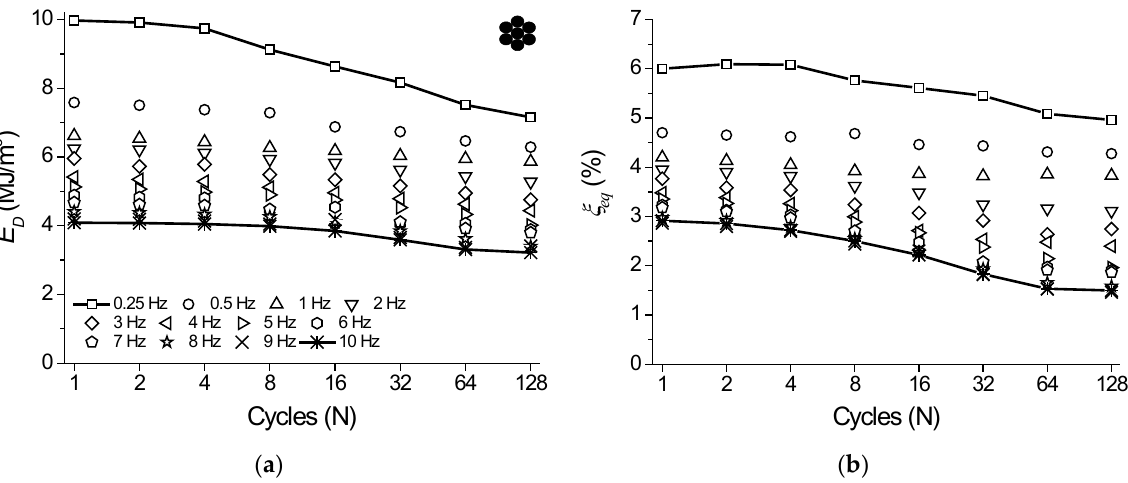
Figure 12. Functional properties variation with cycling as a function of the loading frequencies for the NiTi SMA micro cable. ( a ) Dissipated energy. ( b ) Equivalent viscous damping